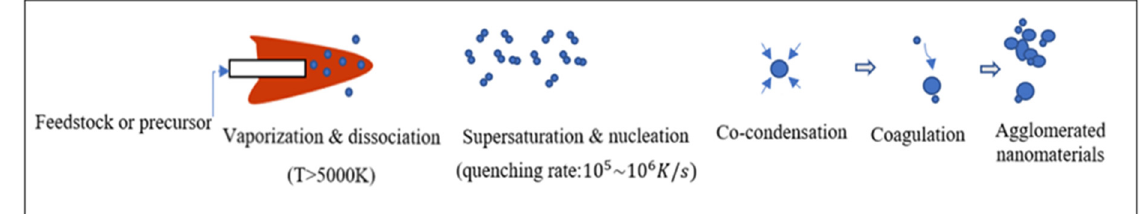
Figure 2. Principle of nanoparticles generation by thermal plasma.